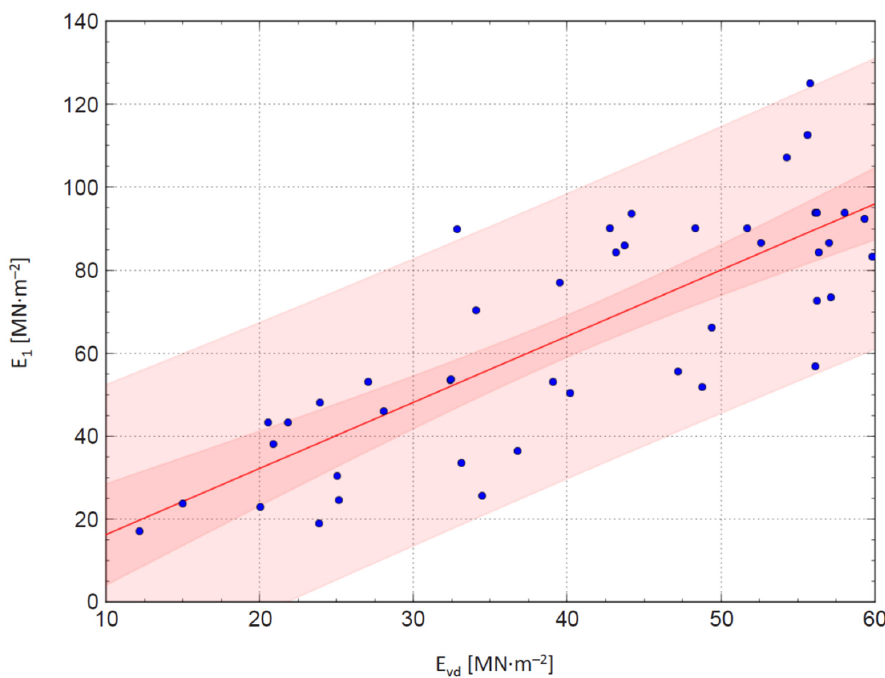
Figure 3. Linear regression for the values of dynamic deformation modulus E vd (LFWD Zorn, type ZFG 3000 GPS, 300 mm diameter loading plate, 10 kg drop weight), and primary deformation modulus E 1 (PLT, 300 mm diameter loading plate) for the entire data set included in the study (n = 245, r = 0.64).